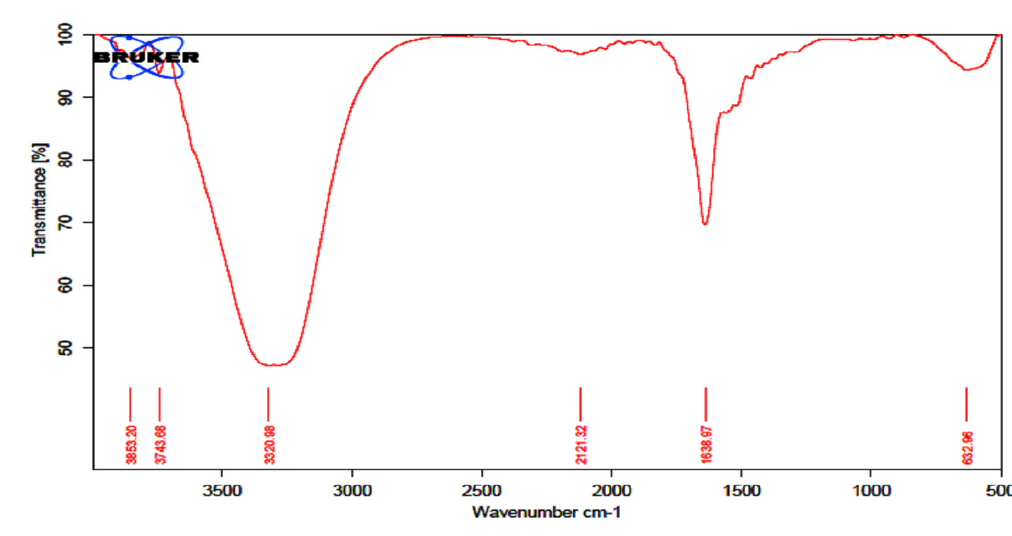
Fig. 7 . FTIR spectrum of the extracts bioactive compounds isolated from Streptomyces sp. MK388207 strain